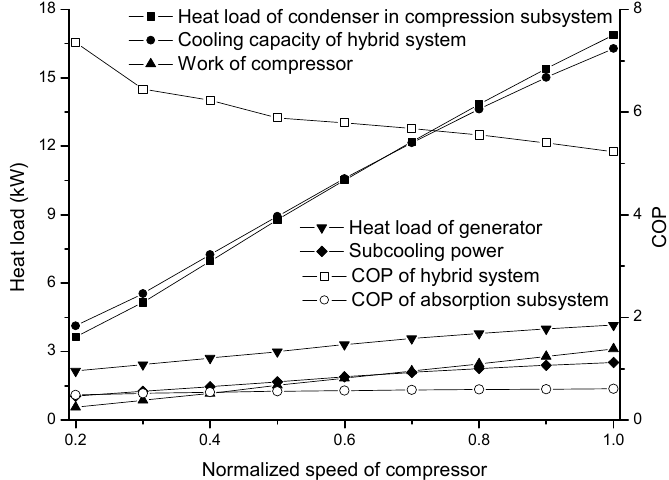
Figure 12. Performance with the flow rate of circulation water in subcooler.